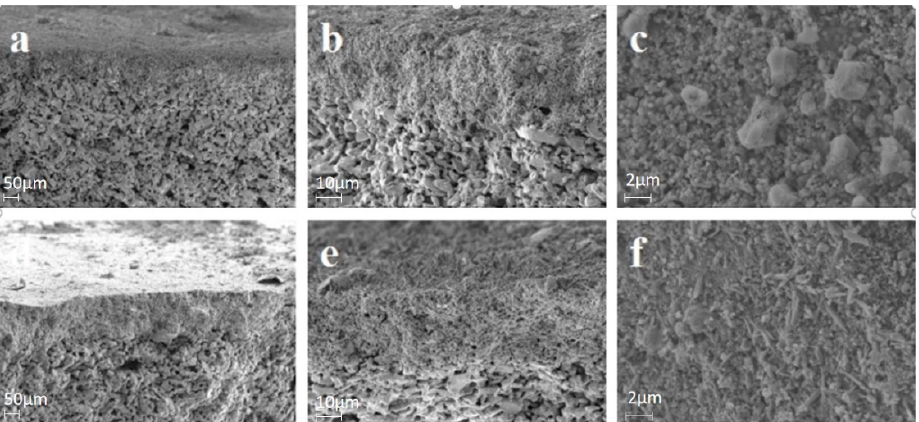
Figure 6. SEM characterization of ceramic membranes before and after use in the combined process: ( a , d ) are the cross-sections of CM and Mn-Fe-CM before use, ( b , e ) are the cross-sections of CM and Mn-Fe-CM after use, ( c , f ) are the surfaces of CM and Mn-Fe-CM after use. AFM was used to study the morphology and roughness of CM and Mn-Fe-CM before and after use, which could veritably reflect the surface contamination of the ceramic